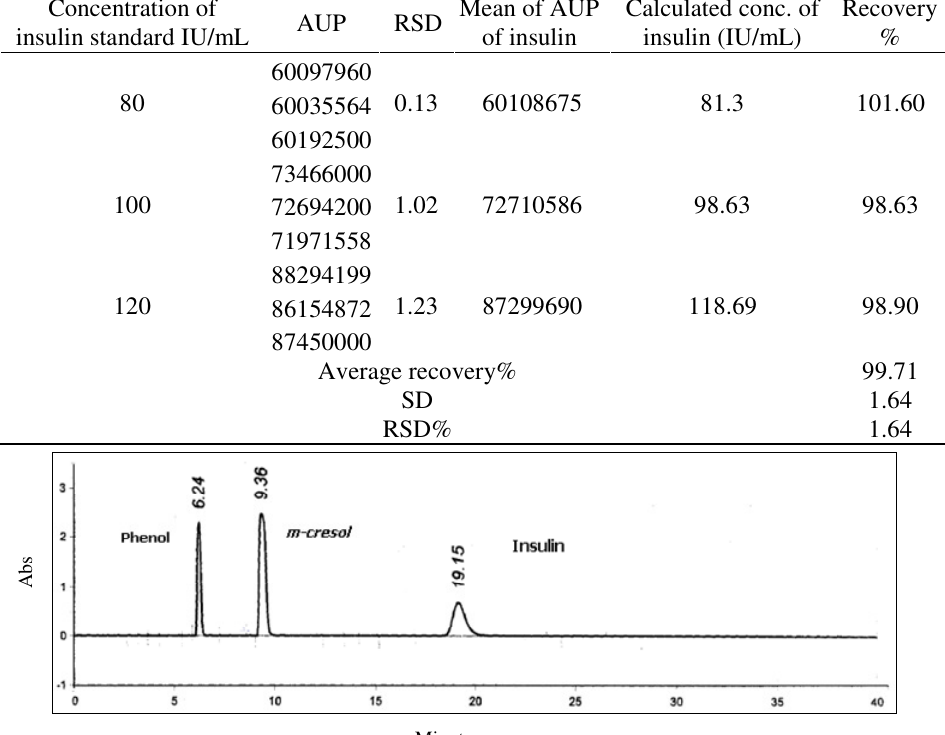
Table 8. Application of the modified RP-HPLC method for the determination of insulin in bulk crystals from commercial supplier Concentration of